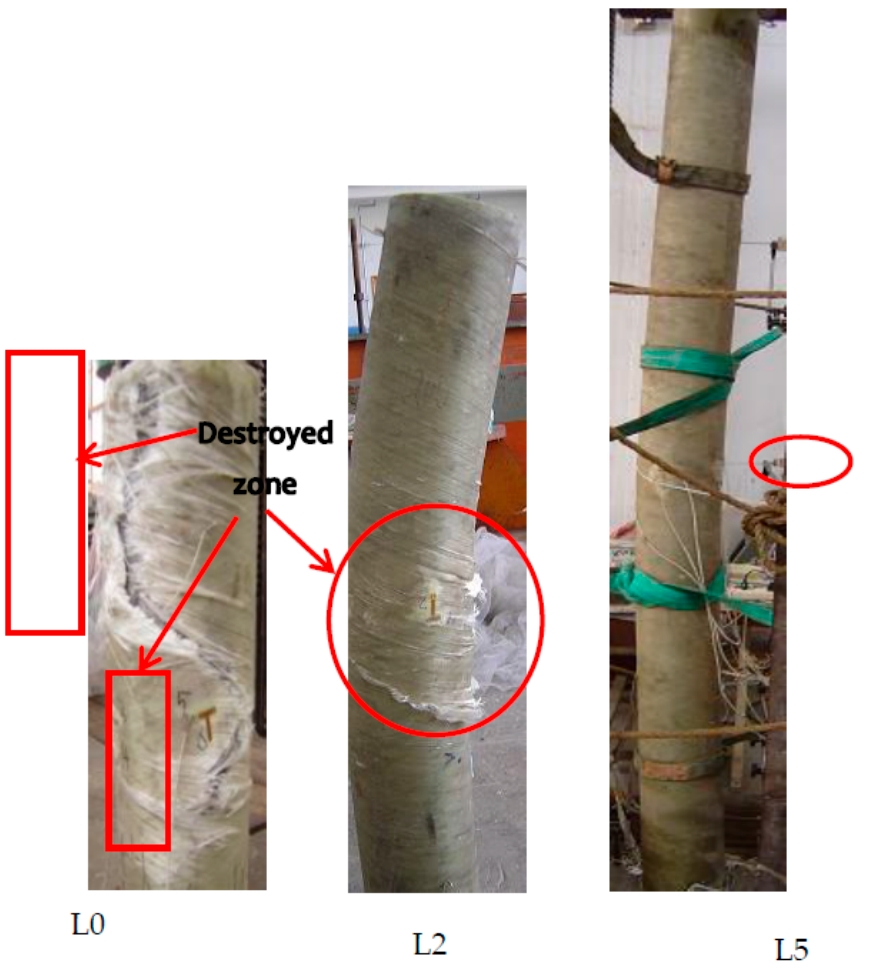
Figure 2. Typical failure modes of composite slender columns.